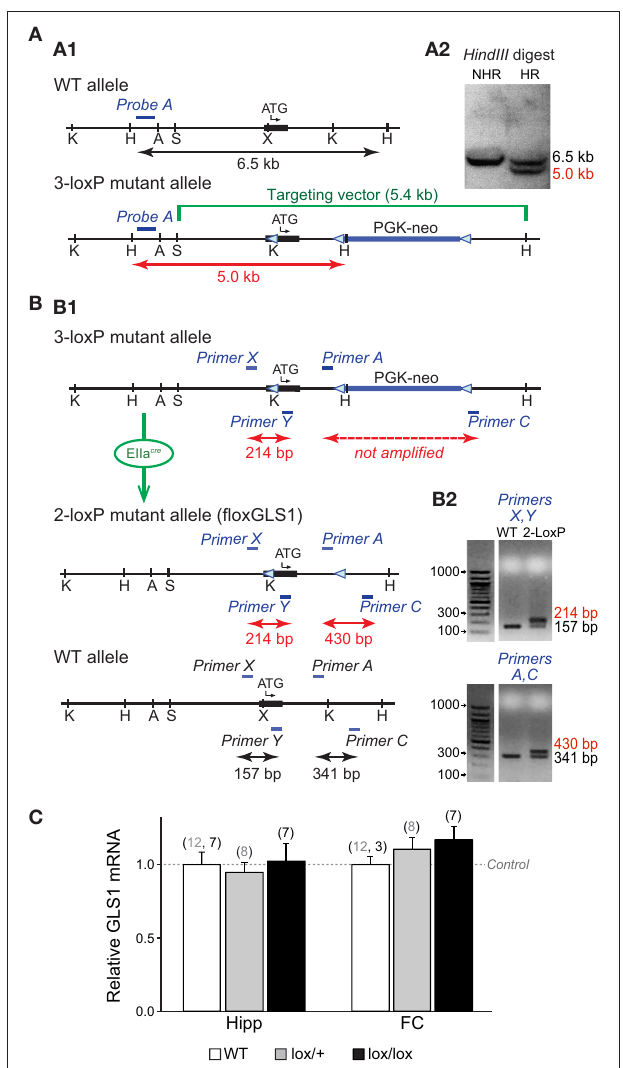
FIGURE 1 | Generation of conditional floxGLS1 mice. (A) Insertion of 3-loxP construct into the GLS1 gene. (A1) A targeting construct engineered with loxP sites flanking exon 1 (thick black line with transcription start ATG codon indicated) of the GLS1 gene encoding glutaminase was inserted into the endogenous GLS1 locus by homologous recombination. The targeting vector (green) also contained a floxed PGK-neo-cassette (thick blue line) for positive selection of the ES cell clones. The blue bar indicates the position of external Probe A (blue), used for Southern analysis, while the black arrow indicates the length of the expected wild-type band and the red arrow the length of the expected mutant band. Note that an additional HindIII site was introduced along with the middle loxP site. (A2) In a HindIII digest of ES cell DNA, Probe A hybridized to a 6.5kb band for the WT allele, in contrast to a 5.0kb band for the 3-loxP allele. Results are shown for ES cells with non-homologous recombination (NHR) and homologous recombination (HR). (B) Breeding floxGLS1 mouse. (B1) 3-loxP mice were crossed with EIIa cre partial deletor mice to remove the floxed PGK-neo cassette. 2-loxP progeny were identified by PCR genotyping using two primer pairs flanking the loxP sites. Blue bars indicate the location of the primers. (B2) The PCR gels show genotyping results for two mice. In the top gel, the 5 ′ loxP site was revealed by a 214 bp band, in addition to the WT allele of 157 bp in the mutant mouse (2-loxP). In the bottom gel, the 3 ′ loxP site was revealed by a 430 bp band, in